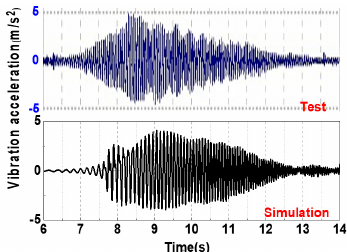
Figure 9. Test and simulation of transverse rope vibration acceleration at 0.5 m above the cage.